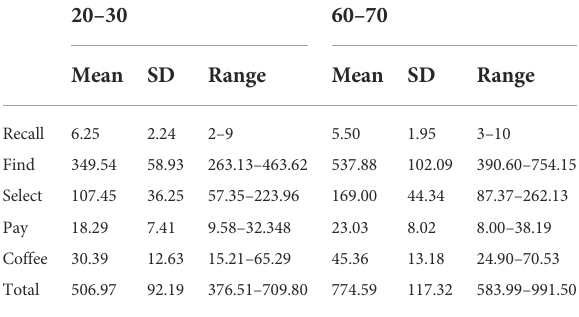
TABLE 4 Study 2 descriptive statistics for VStore outcomes in seconds strati fi ed by group.